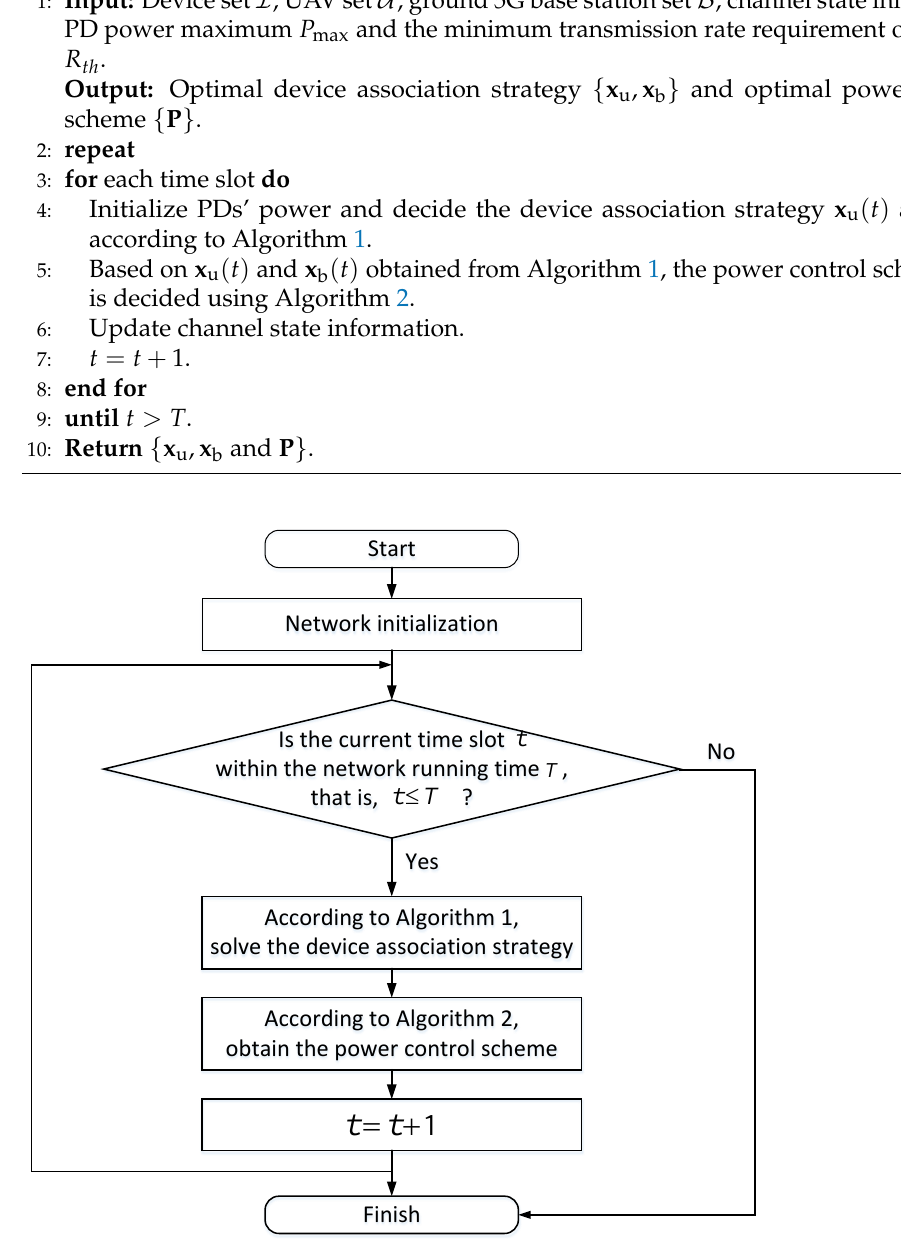
Figure 3. Algorithm 3